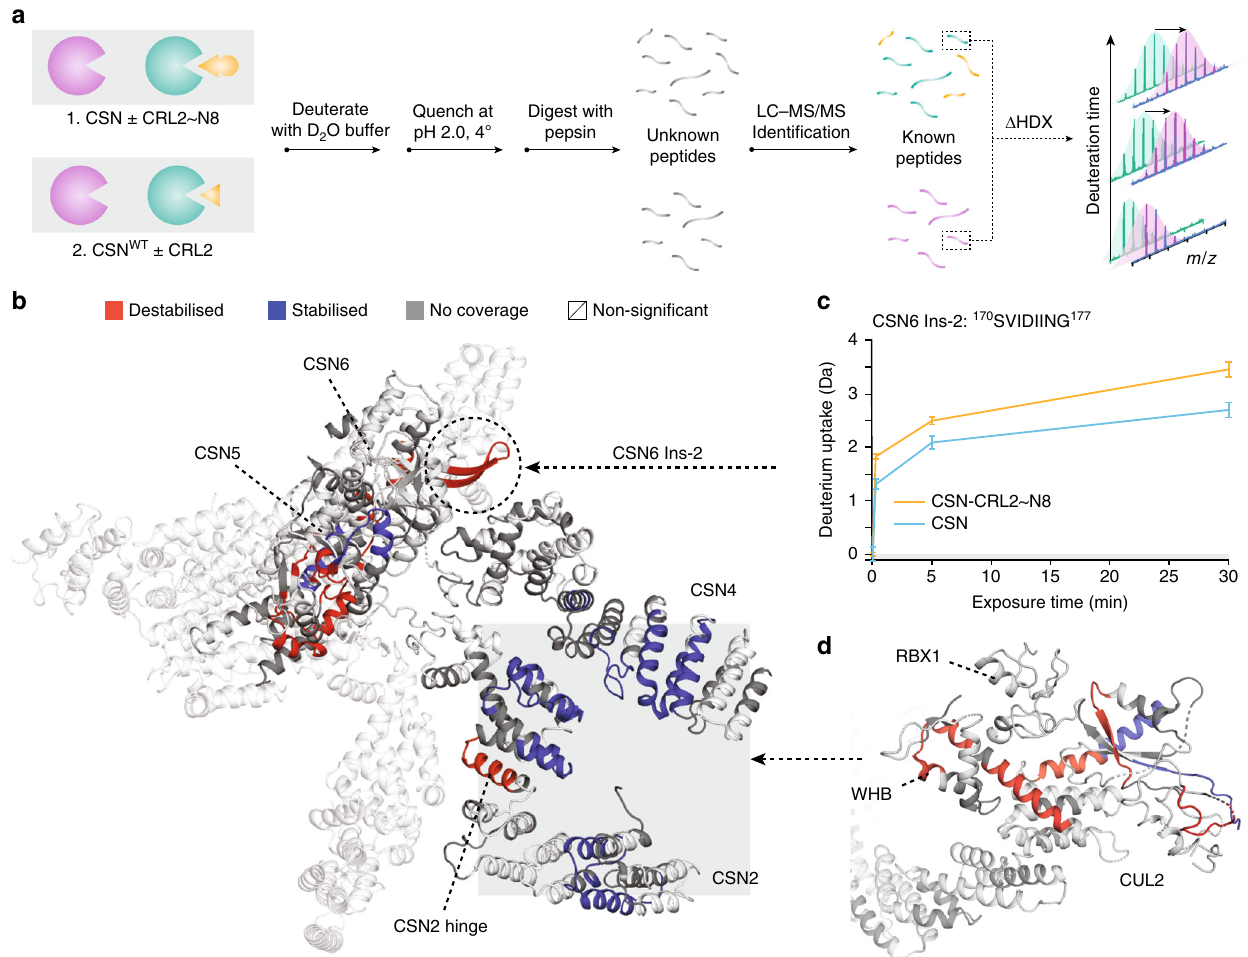
Fig. 3 Effect of NEDD8 on the CSN4/CSN6 interface. a Investigating the effect of CRL2~N8 and CRL2 binding on CSN and CSN WT , respectively. The two experiments involve deuterating the complexes for 0.25, 5 and 30 min time points, a quench step to halt the deuteration, and digestion to the peptide level. Peptides are then identi fi ed using liquid chromatography-tandem mass spectrometry (LC-MS/MS) and a database search. b Effect of CRL2~N8 binding on the CSN. c Relative deuterium uptake over 30 min for the CSN6 Ins-2 peptide ( 170 SVIDIING 177 ). Error bars indicate the deuterium uptake standard deviation for triplicate measurements ( N = 3). d Effect of CSN on the C-terminal domain of CRL2~N8. Colour scheme follows that of b . Source Data are provided as a Source Data fi